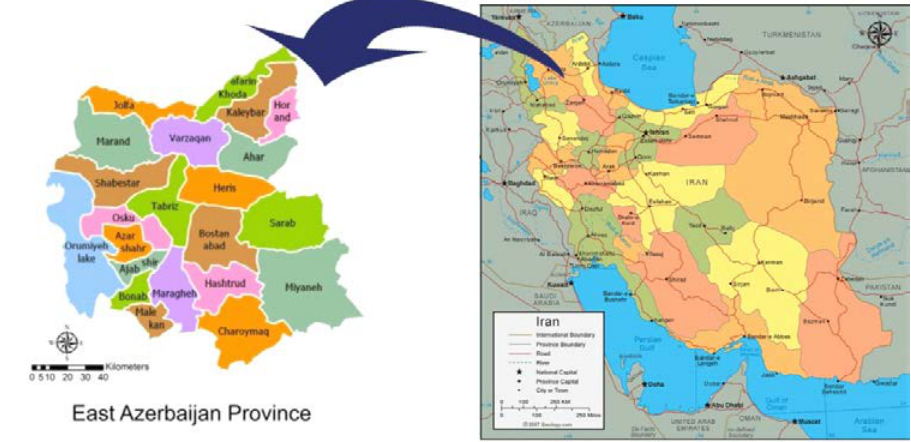
Fig. 1: Location of the case study area within Iran and East-Azerbaijan